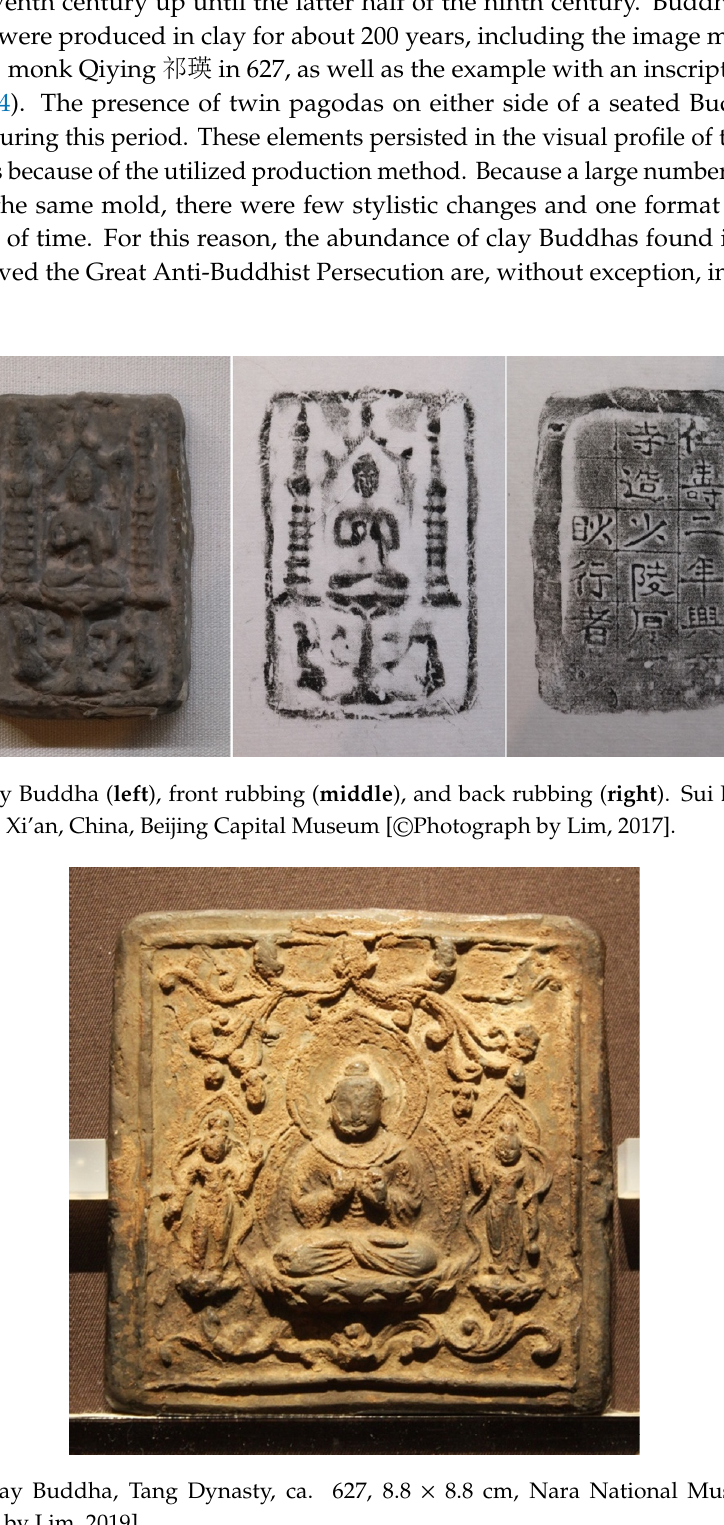
Figure 13. Clay Buddha, Tang Dynasty, Ximing temple, Xi’an, China, Zhongguo shehuikexueyuan kaoguyanjiusuo, [Source: (KKKFH 1995, plate 77)]. Figure 14. Clay Buddha ( left ), front rubbing ( middle ), and back rubbing ( right ) . Tang Dynasty, 815, Beijing Capital Museum, China [©Photograph by Lim, 2017]. The image of a seated Buddha in Dharmacakra-mudr ā was also a favored subject in Unified Silla and Japan during the latter half of the seventh century and into the eighth century. Some well-known